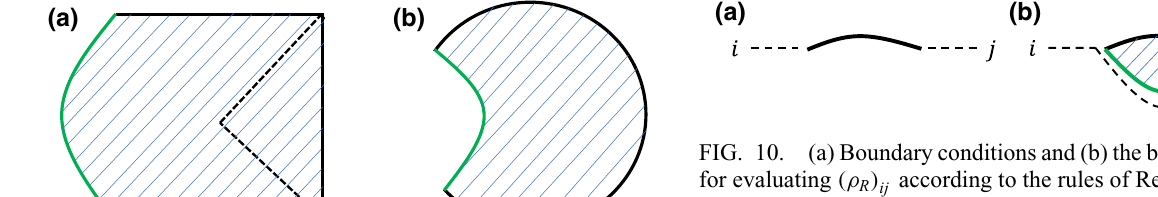
FIG. 11. (a) Boundary conditions, and (b),(c) show two contributions to the bulk path integral for evaluating Z ( R ) according to the rules of Ref.